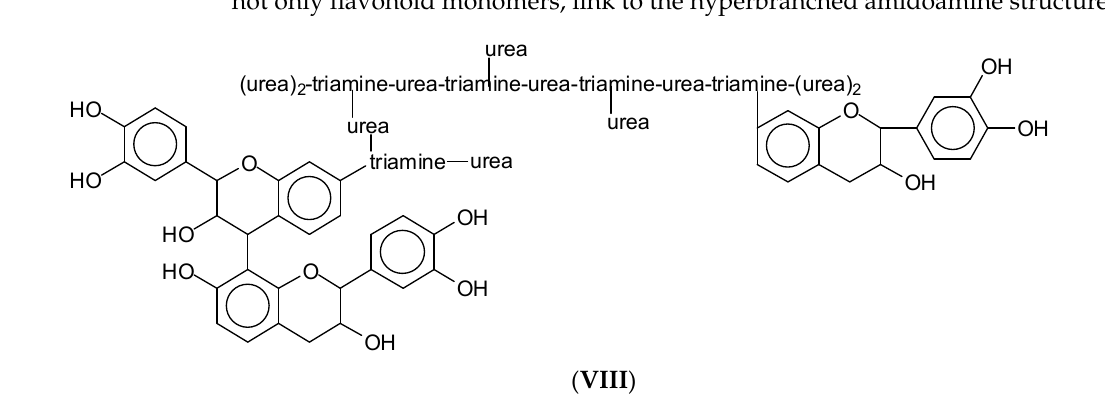
Figure 9. An example of a detected structure with two flavonoid units linked to a triamine-urea hyperbrached network part.